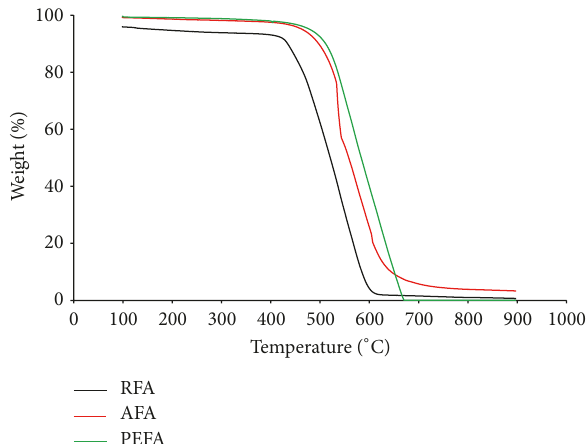
Figure 8: Thermogravimetric (TG) measurements of RFA, AFA, and PEFA.